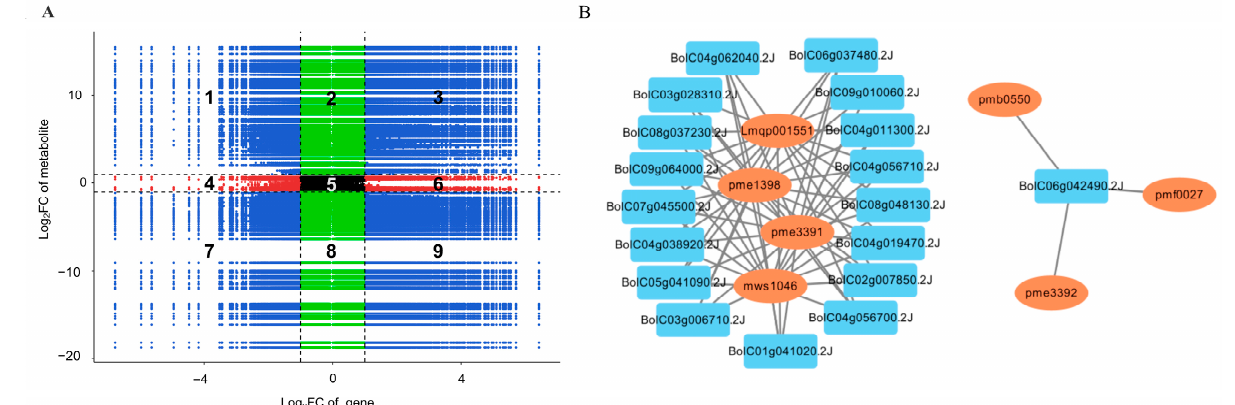
Figure 7. Correlation analysis of anthocyanin-related genes and metabolites. ( A ) Nine-quadrant plot. ( B ) Correlations between anthocyanin-related genes and metabolites.